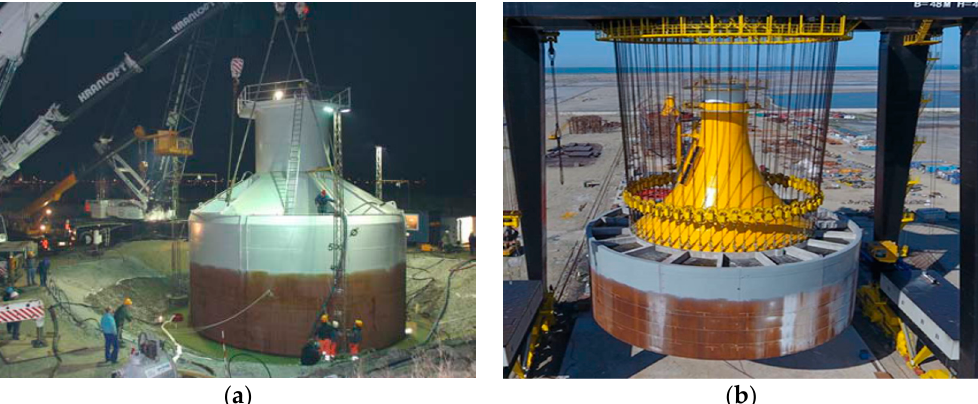
Figure 1. The prototypes of wide-shallow bucket foundation: ( a ) Frederikshavn, Denmark [17]; ( b ) Xiangshui, China.